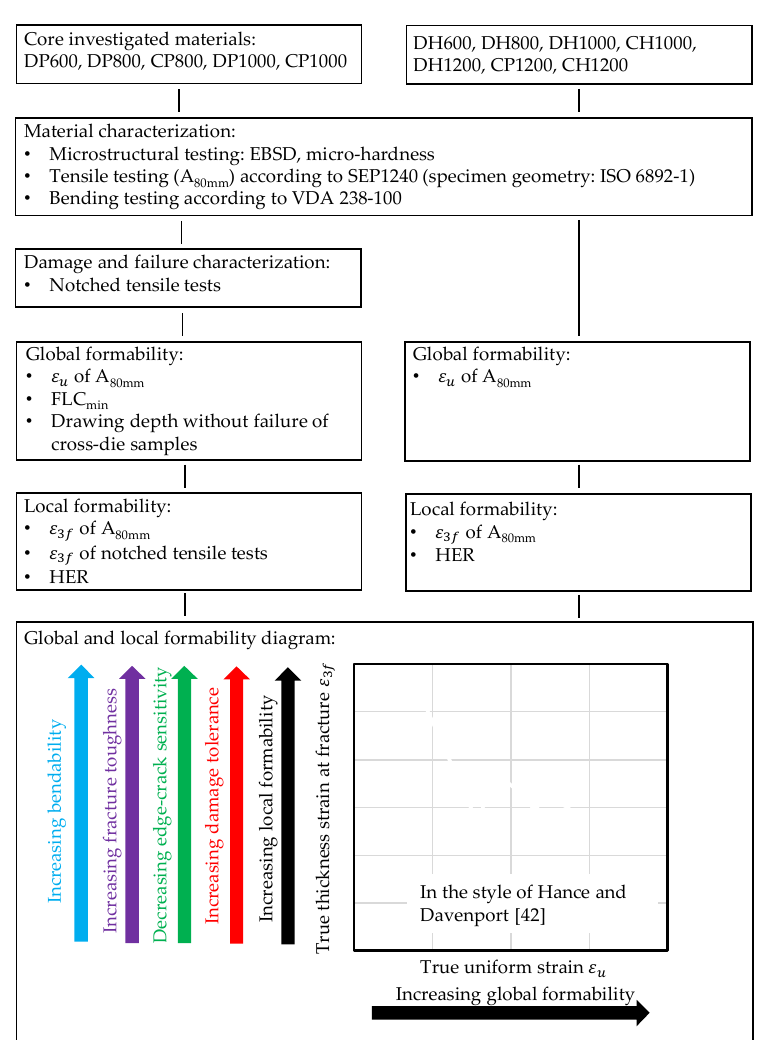
Figure 6. Methodology of investigations.